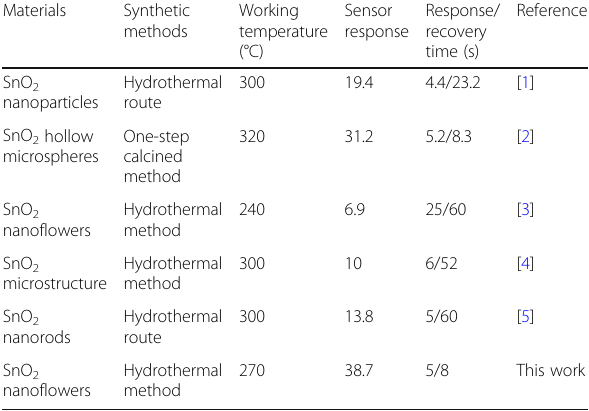
Table 2 The comparison of ethanol sensing performances of SnO 2 materials based on different fabricated approaches reported in other literatures and this work Materials Synthetic